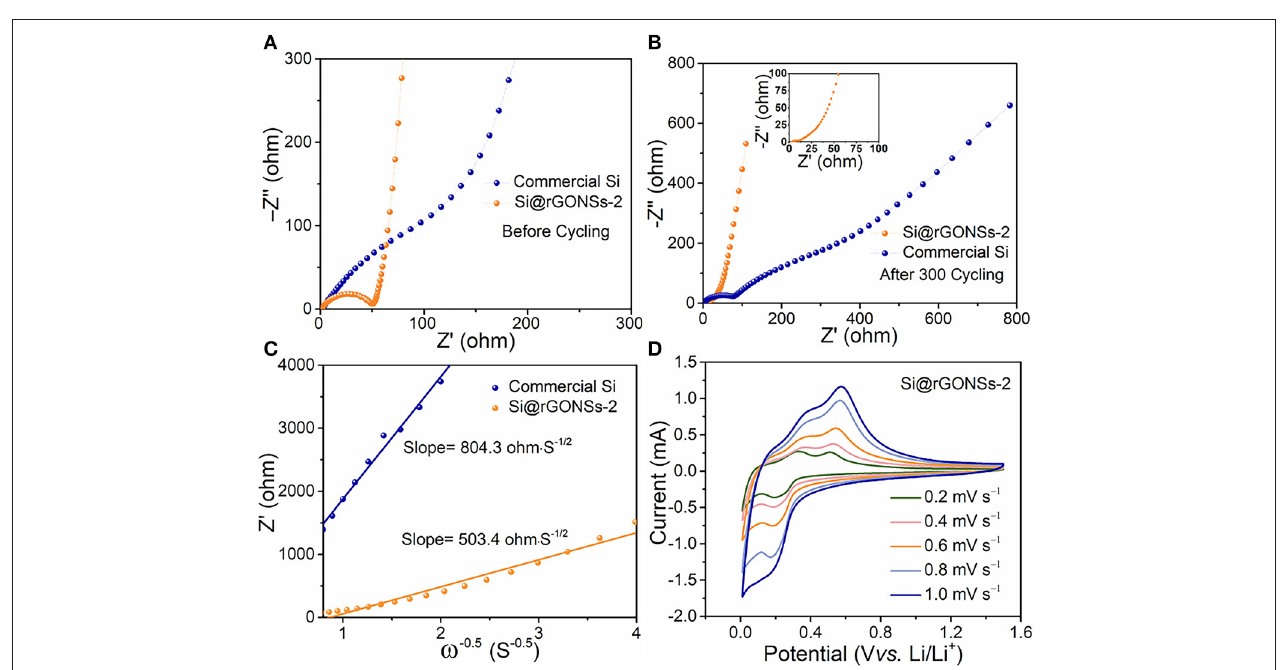
FIGURE 4 | (A) Nyquist plots of the pure silicon and Si@rGONSs-2 in fresh state, (B) Nyquist plots of the pure silicon and Si@rGONSs-2 after 300 cycles, (C) the corresponding liner fits (relationship between Z ′ and ω − 1 / 2 ) in low-frequency region derived from (A) , and (D) CV profiles of the Si@rGONSs-2 at scan rates from 0.2 to 1mV s − 1